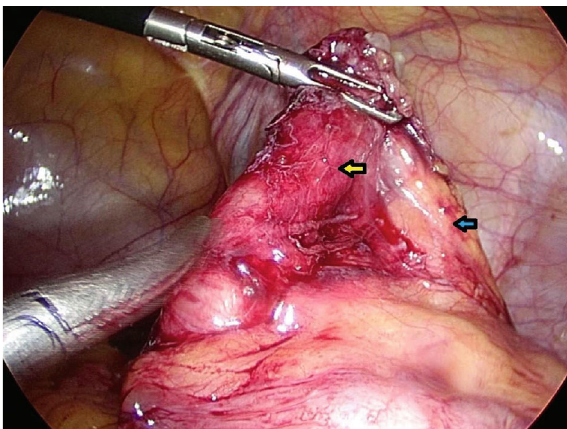
Figure 3: Operative picture of the stump (yellow arrow) and mesentery (blue arrow) after the gelatinous material has been separated. The tip was attached to the mucoid jelly-like material and shows abnormal